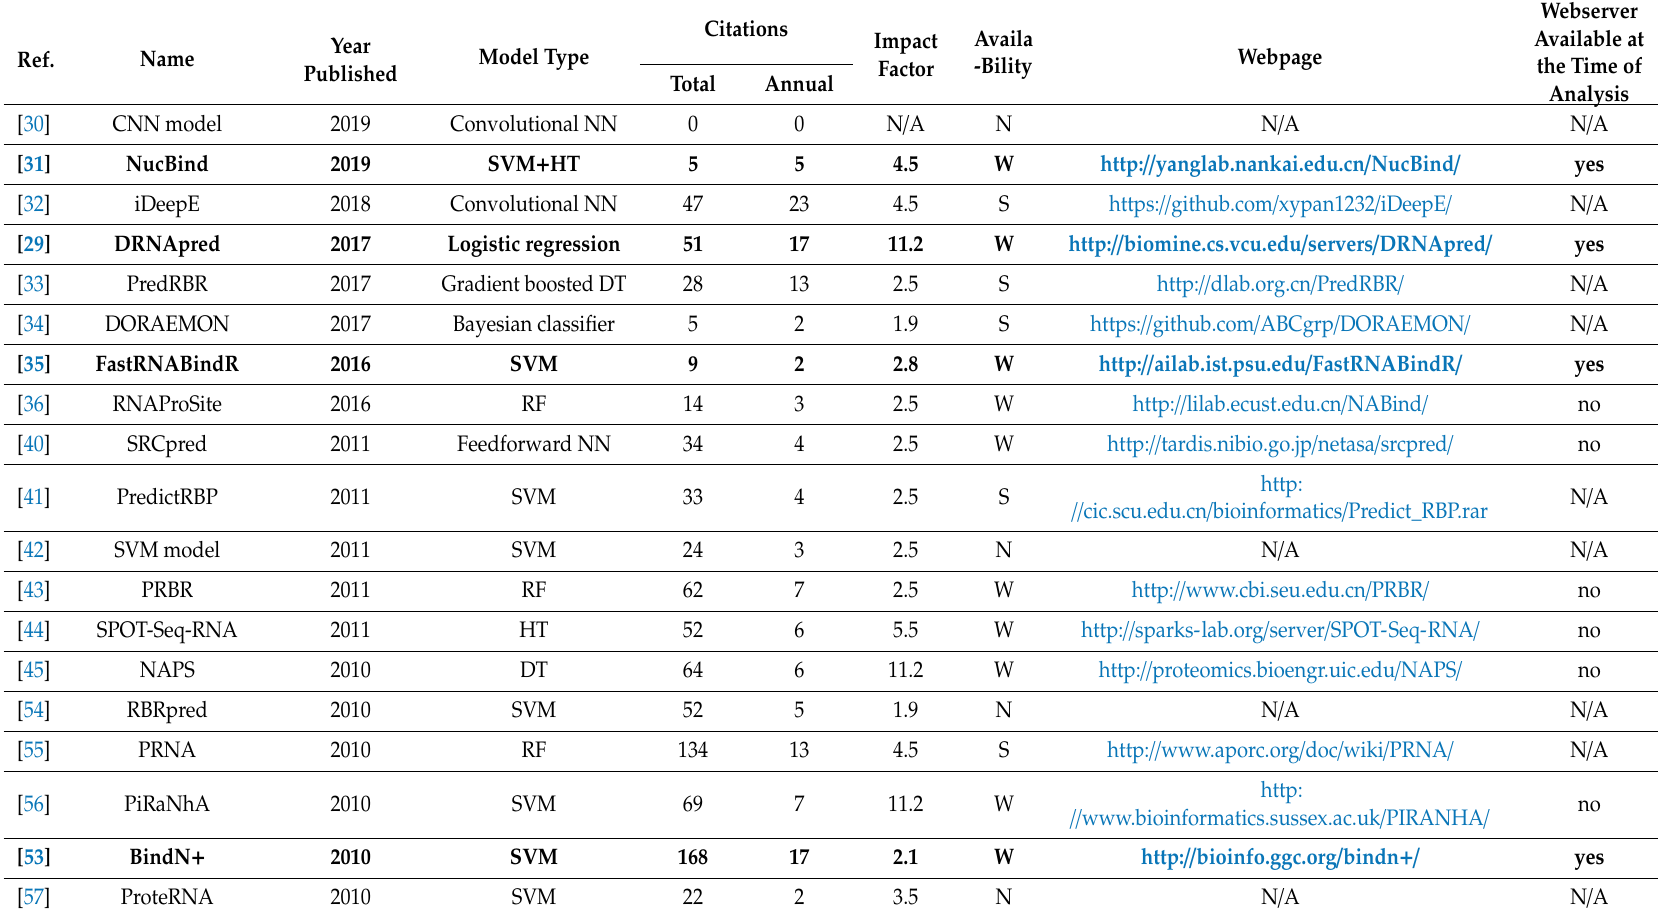
Table 2. Partner-agnostic sequence-based predictors of